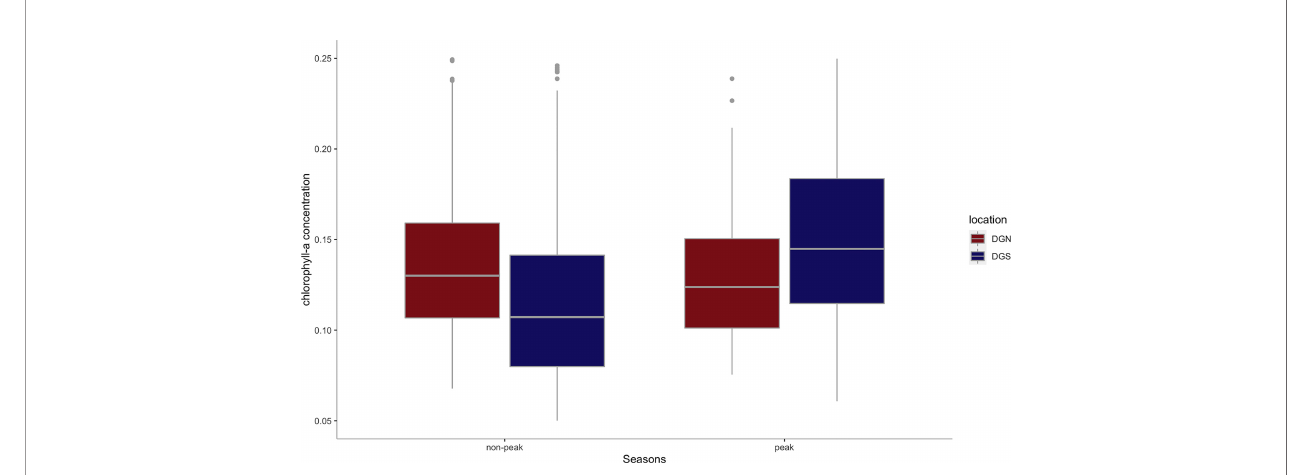
FIGURE 7 | Boxplot of the mean chlorophyll-a concentration(mg/m 3 ) for DGS (n = 13 from 2002 to 2014) and DGN (n = 18 from 2002 to 2019) during the corresponding peak seasons and non-peak seasons. Boxes represent interquartile ranges (IQR); solid white lines represent medians; black lines encompass data range 1.5*IQR below and above IQR; dots represent potential outliers.